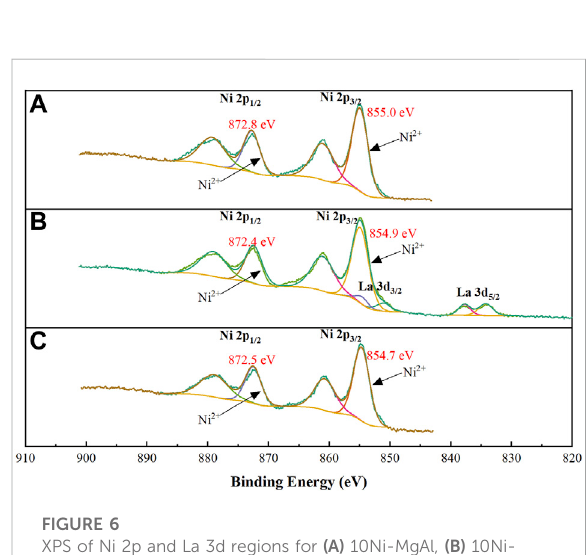
FIGURE 6 XPS of Ni 2p and La 3d regions for (A) 10Ni-MgAl, (B) 10Ni- 5La/MgAl and (C)